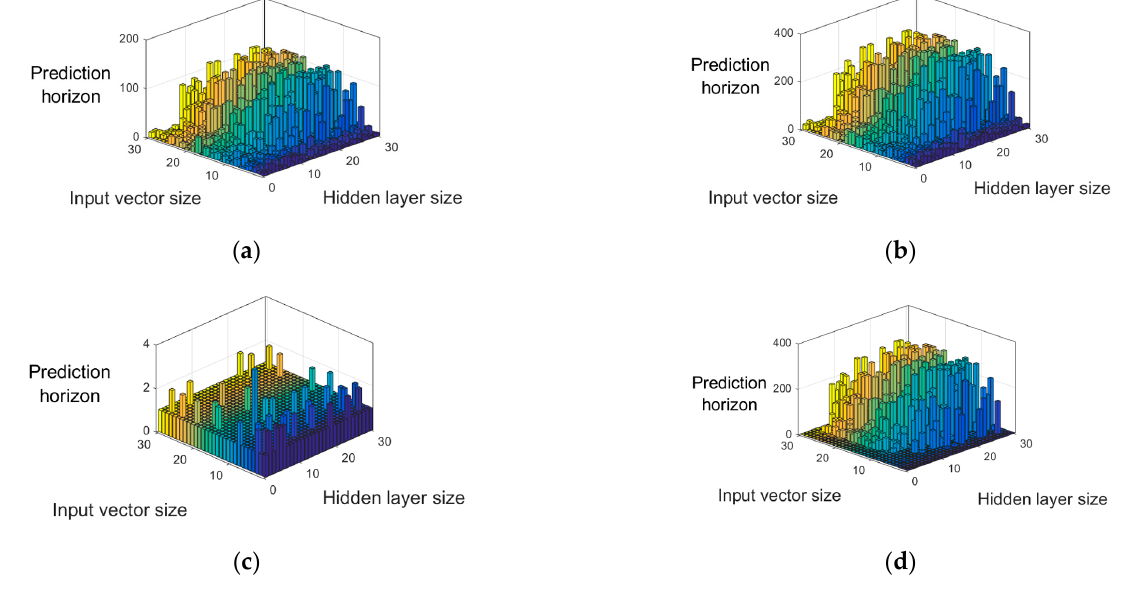
Figure 8. Simulation results for individual evaluation criteria: ( a )—criterion I, ( b )—criterion III, ( c )—criterion II, ( d )—criterion